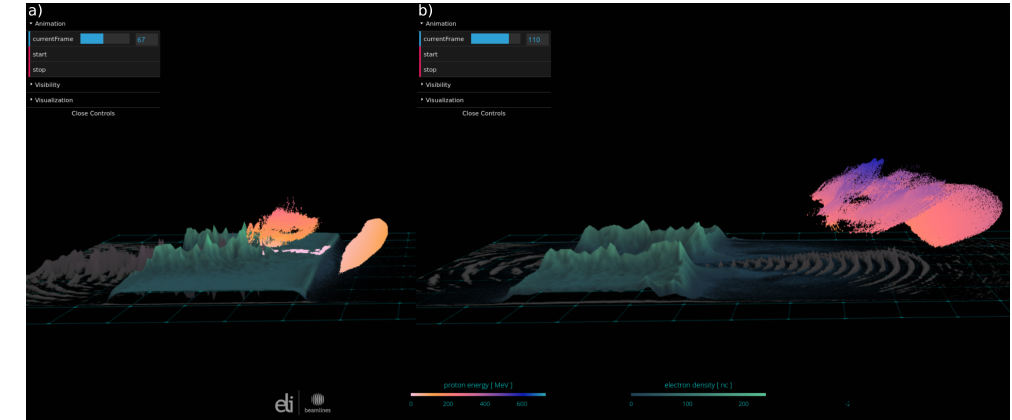
Figure 3. VBL visualization of different proton populations using the hydrogen target: ( a ) at time frame 67, ( b ) at time frame 110. The dots represent the simulated protons (only protons that exceed 300 MeV at the end of the simulations are included); the vertical height and color denote their energy using the white–red–blue scale. Laser pulse intensity is represented by the gray scale, electron density by the turquoise scale, and both values are also visualized using the vertical height. The interactive VBL application of the full time evolution is accessible online [84].